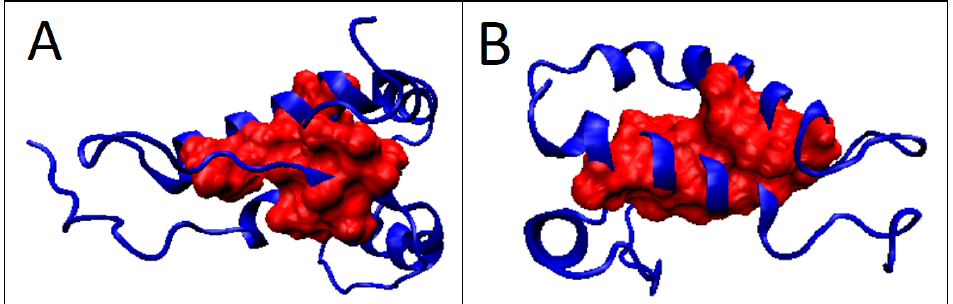
Figure 11. 3D presentation of proteins identified as prion-like. ( A ) 1LG4; ( B ) 1I17. Hydrophobic core marked in red.